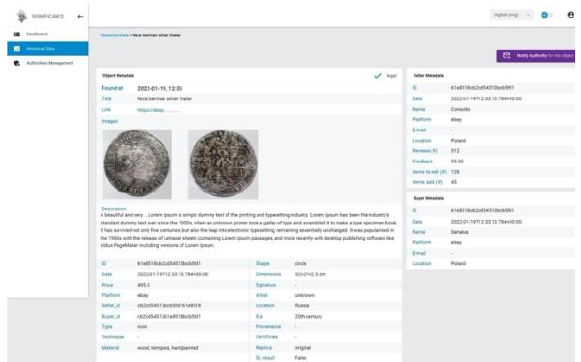
Figure 9. SIGNIFICANCE Platform: Object details